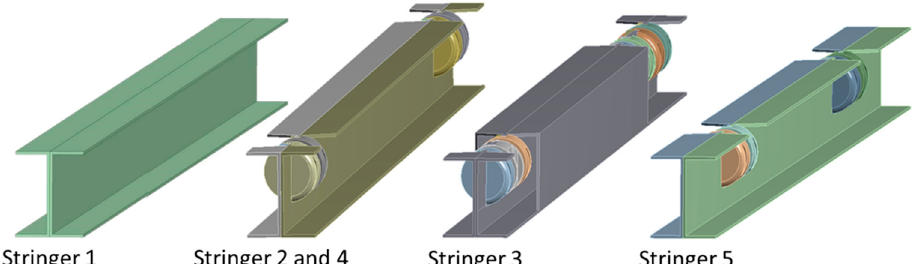
Figure 11. Steel profiles for additional stiffening of the stringers; stringers 1, 2, 4, and 5 are reinforced by a pair of C-section profiles, each, while higher loads at stringer 3 require box-section profiles; cylindrical parts are fittings for the kinematic system; stringer 1 is not connected to the kinematic system and therefore does not possess fittings; the CFRP-portion of each stringers (not shown here) is sandwiched between the two profiles.